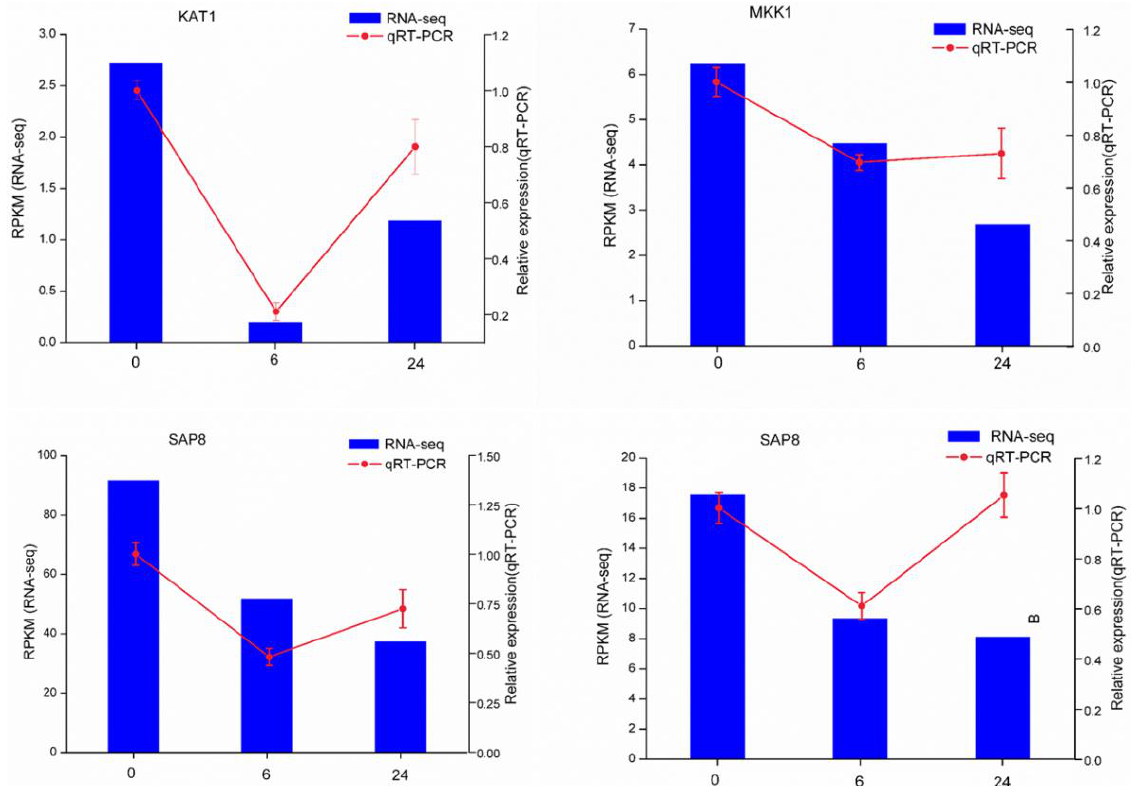
Figure 5. qRT-PCR verification of four selected DEGs. Comparison of RNA-seq data (blue bar) with qRT-PCR data (red line). The normalized RNA-seq expression levels (RPKM) are indicated on the y-axis to the left. The relative qRT-PCR expression levels are indicated on the y-axis to the right. The EF1A gene was used as an internal control. The results of both methods are consistent, with similar gene expression patterns (color figure online).